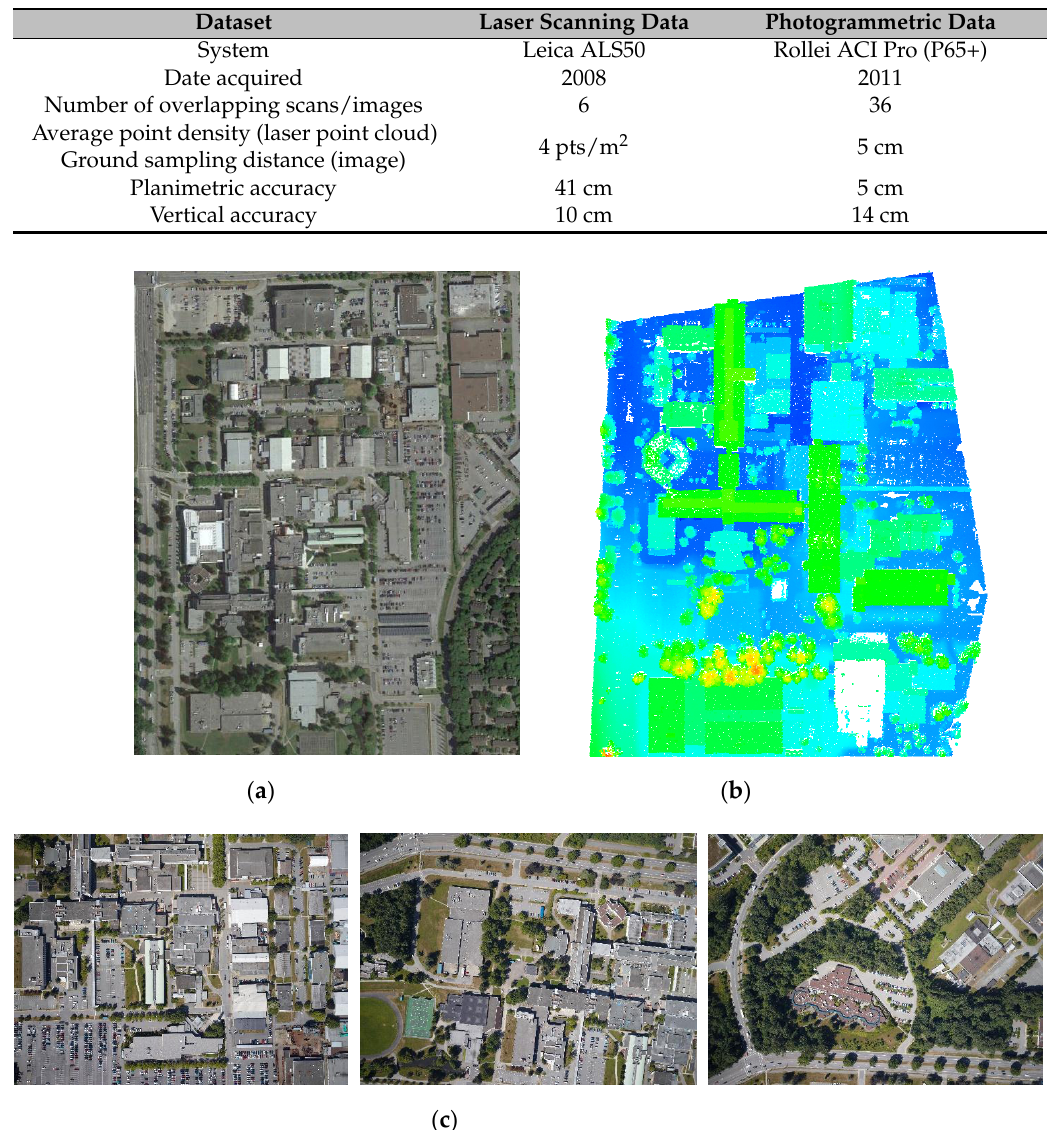
Figure 25. ( a ) An overview of the area of interest (in Burnaby, BC, Canada) from Google Earth; ( b ) laser scanning point cloud colored according to height; and ( c ) three of the captured images over same area.